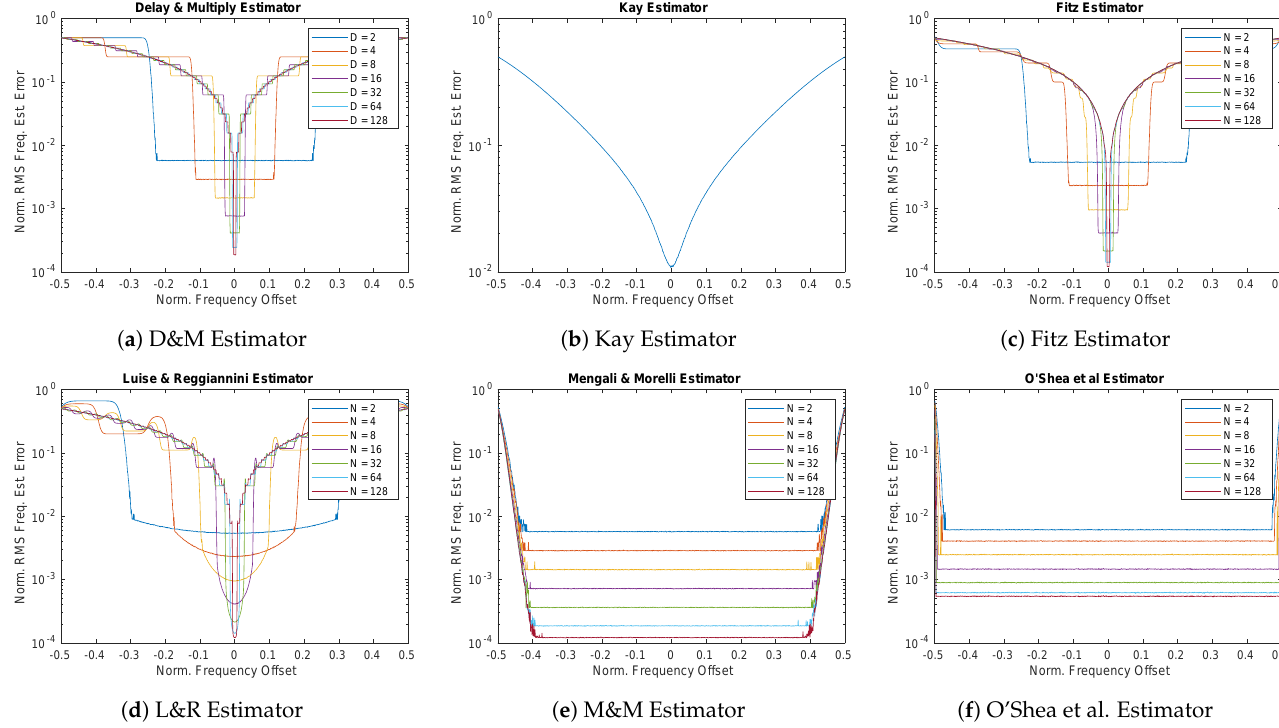
Figure 15. Frequency Estimators Performance, frequency offset sweep, E b / N 0 = − 0.52